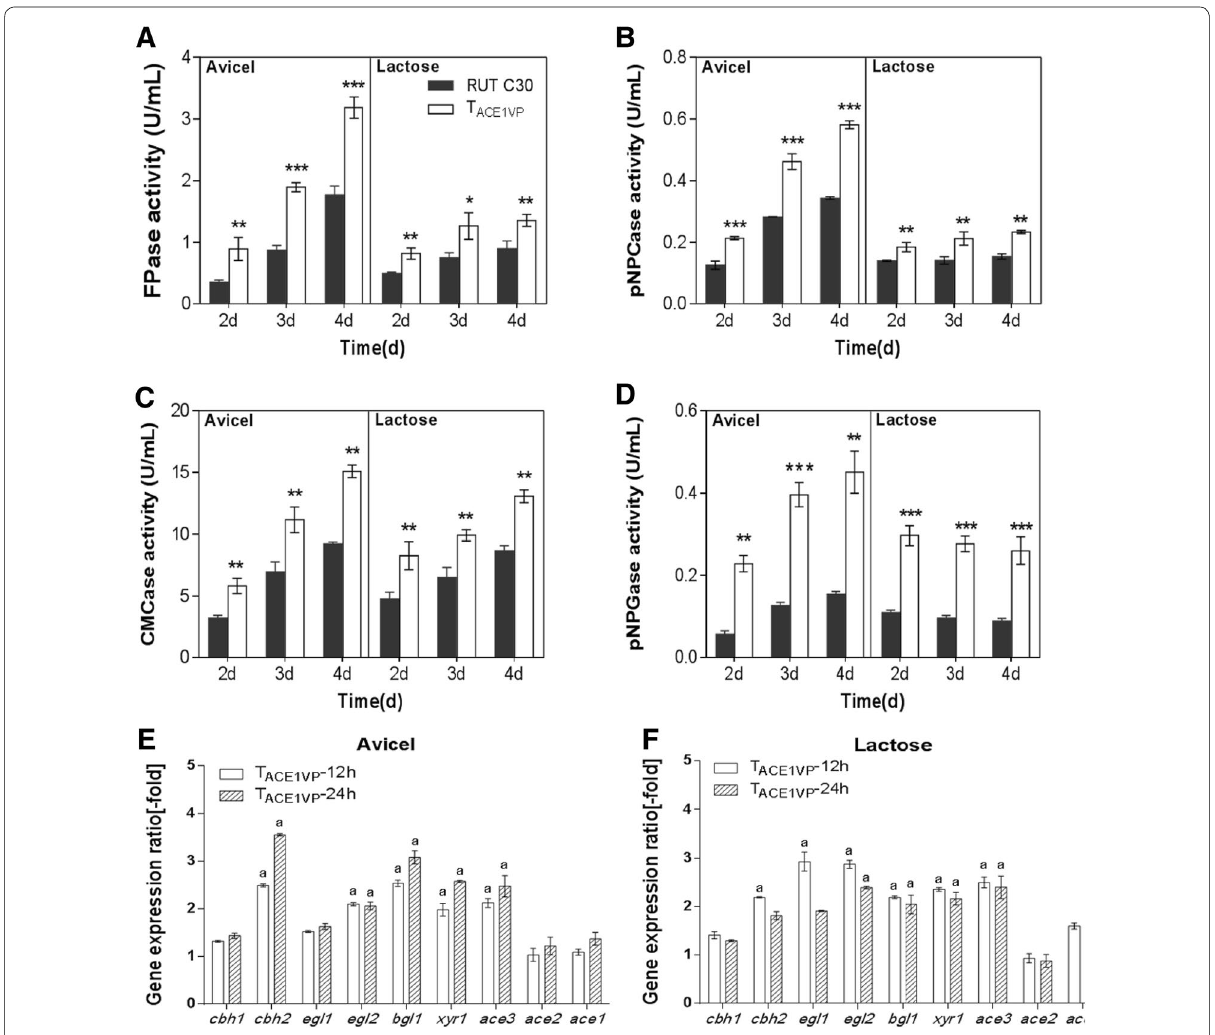
Fig. 5 Cellulase production and a comparison of transcript levels of cellulase-related genes between T ACE1VP and RUT C30. FPase ( A ), p NPCase ( B ), CMCase ( C ), and p NPGase ( D ) activities of RUT C30 and T ACE1VP after the switch from glycerol to 20 g/L Avicel or lactose. Enzymatic activities were measured at 2, 3, and 4 days after the transfer. Error bars show the respective standard deviations of three biological replicates; asterisks indicate significant differences (* P 0.05; ** P 0.01; *** P 0.001; n.s. not significant) between the transformants and RUT C30, as assessed by Student’s t ≤ ≤ ≤ test. Expression ratios of cellulase-related genes on 20 g/L Avicel ( E ) or lactose ( F ) for 12 and 24 h after the switch from glycerol. The data on T XYR1VP transformants were normalized to the corresponding gene expression at the same time points in RUT C30. Values represent the mean of three biological replicates, and the error bars denote standard deviation. Gene expression ratios greater than twofold or less than 0.5-fold are marked